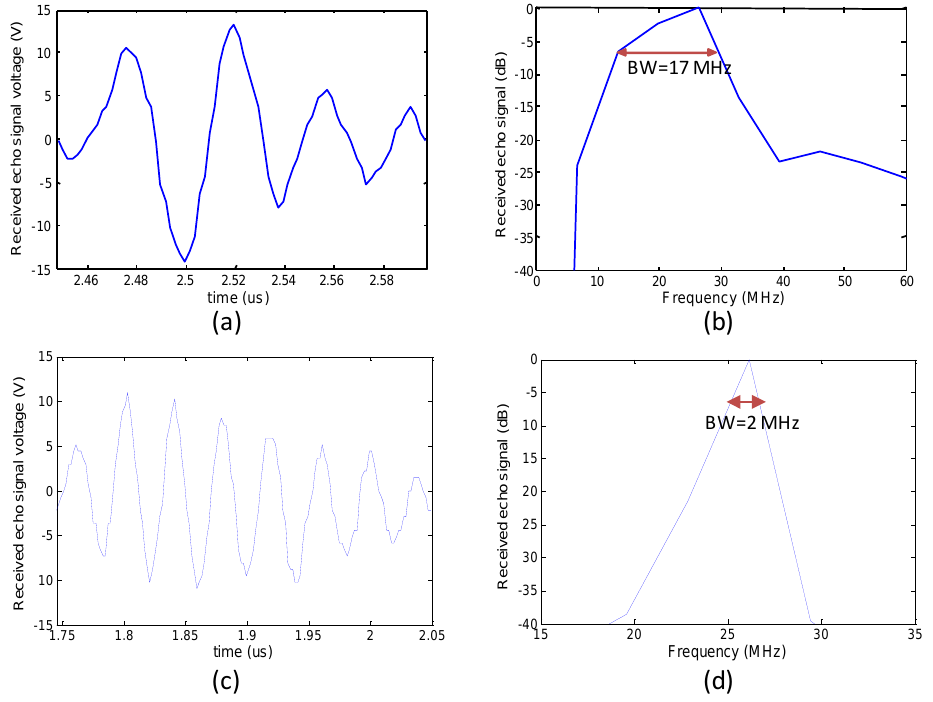
Figure 9. Pulse-echo response of the fabricated ultrasonic transducer: ( a ) Fabricated curved transducer with gradient acoustic impedance matching layer; ( b ) Fourier transform spectrum of (a); ( c ) The same sized spherically-shaped transducer uses a 18 μm thick parylene layer as an acoustic matching layer for comparison; ( d ) Fourier transform spectrum of